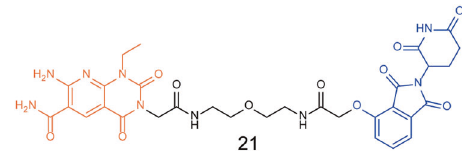
Fig. 6 The representative PROTAC targeting